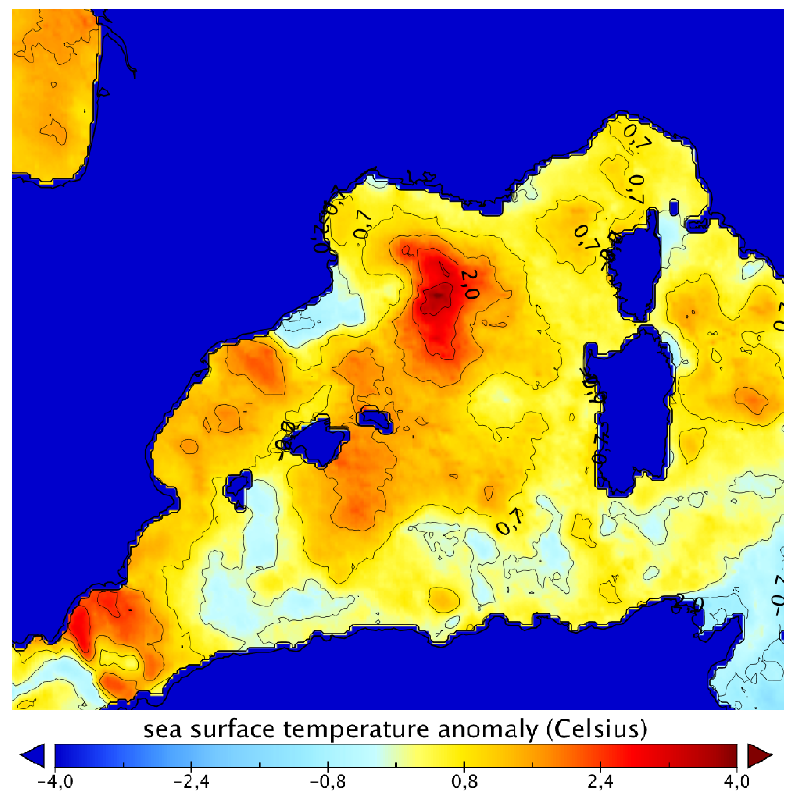
Figure 3. SST anomaly produced by the Mediterranean Forecasting System (MFS INGV, [24]) on 8 November 2011, consisting of the difference between analysed SST from MFS and the climatology 1955–2004 supplied by the Nucleus for European Modelling of the Ocean (NEMO), with a variational data assimilation scheme (OceanVAR) for temperature and salinity vertical profiles and satellite Sea Level Anomaly along track data. The model horizontal grid resolution is 1°/16° (ca. 6–7 km) and the unevenly spaced vertical levels are 72 [25]. In this figure, we can see the positive SST anomaly in the western Mediterranean Sea, between 1–3.7 °C, in particular over the formation area of the TLC.